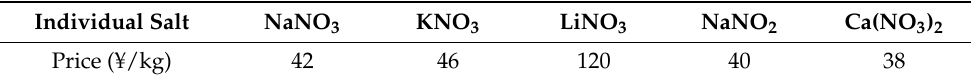
Table 1. Cost price of individual salts (data from the website of Sinopharm Chemical Reagent Co., Ltd. (SCRC)).